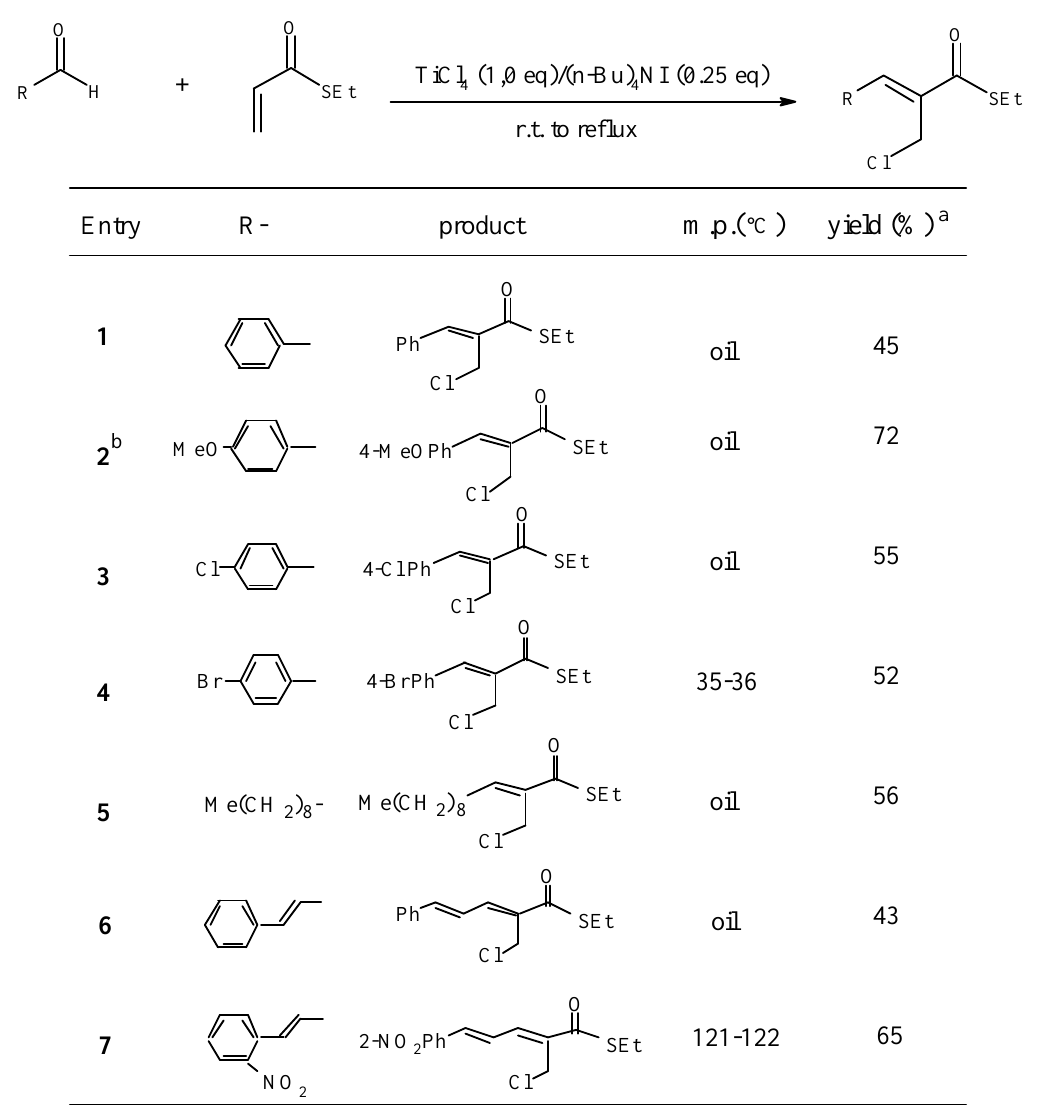
/( n -Bu) NI-Mediated C=C Bond 4 4